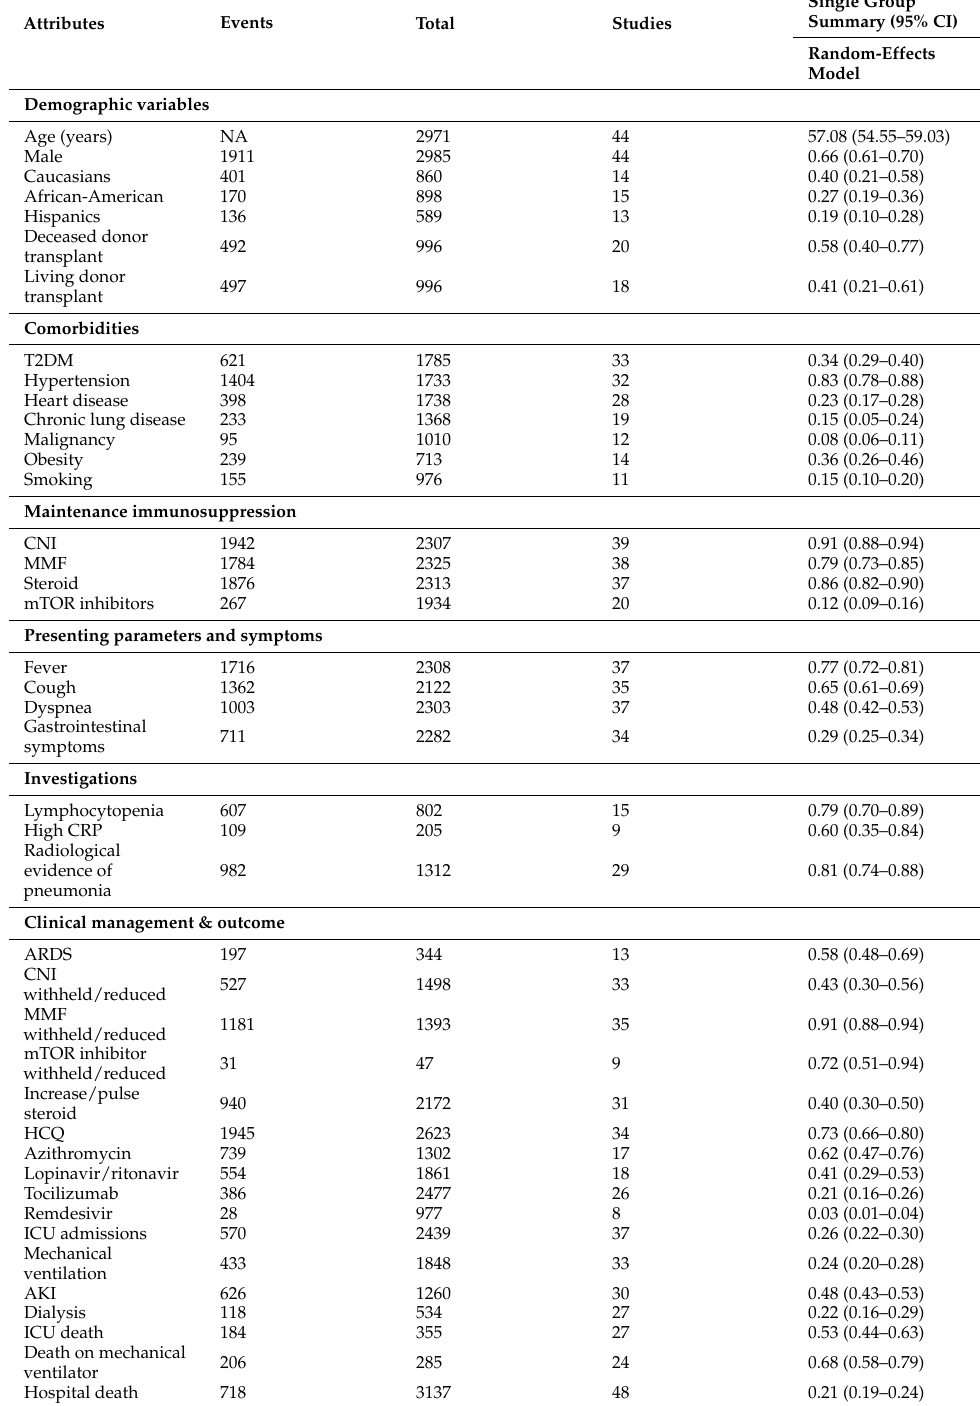
Table A4. Summary statistics outlined as pooled estimates of outcomes of